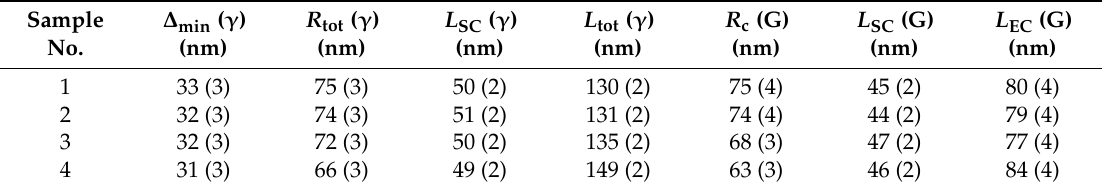
Table 2. Resulting equatorial and meridional characteristic dimensions of the investigated POF samples obtained from distance distribution function ( γ ) and Guinier approximation